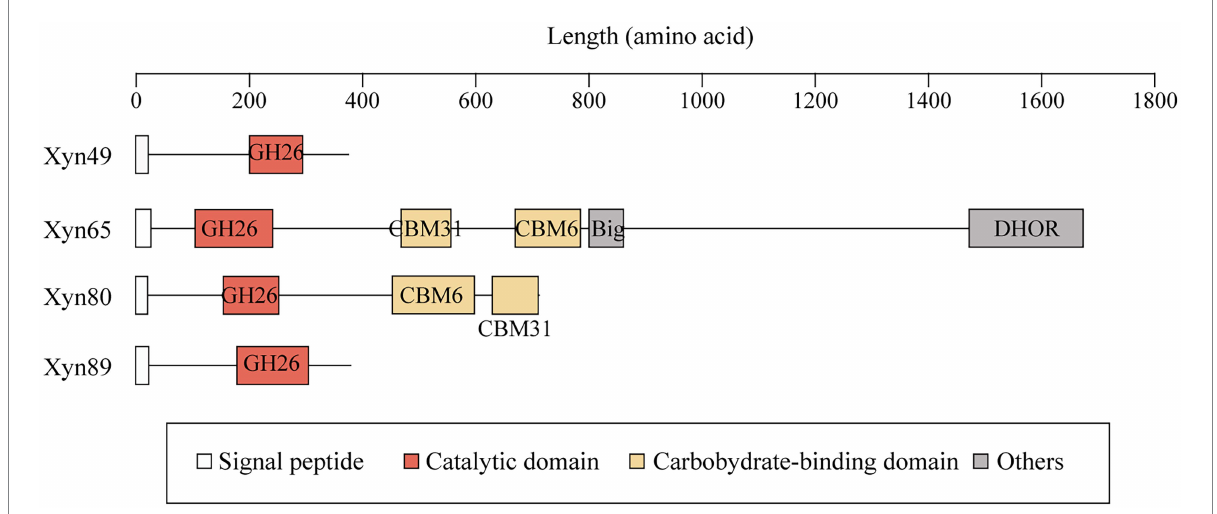
FIGURE 4 The domain architectures of the four 1,3-xylanases secreted by strain HB14 T . Signal peptides were predicted by SignalP 5.0. Domain analysis was performed in the NCBI CDD database and the Pfam database. Domains were illustrated in different colors based on their functional annotations. Big, bacterial immunoglobulin (Ig)-like domain; DHOR, di-haem oxidoreductase